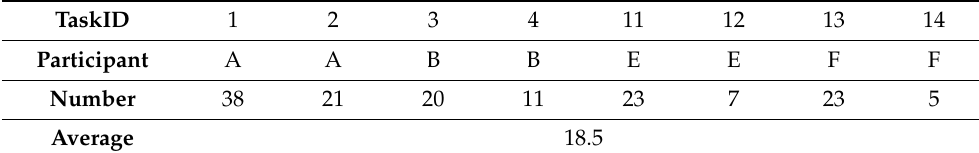
Table 5. Number of conceptions in the non-collaboration group.